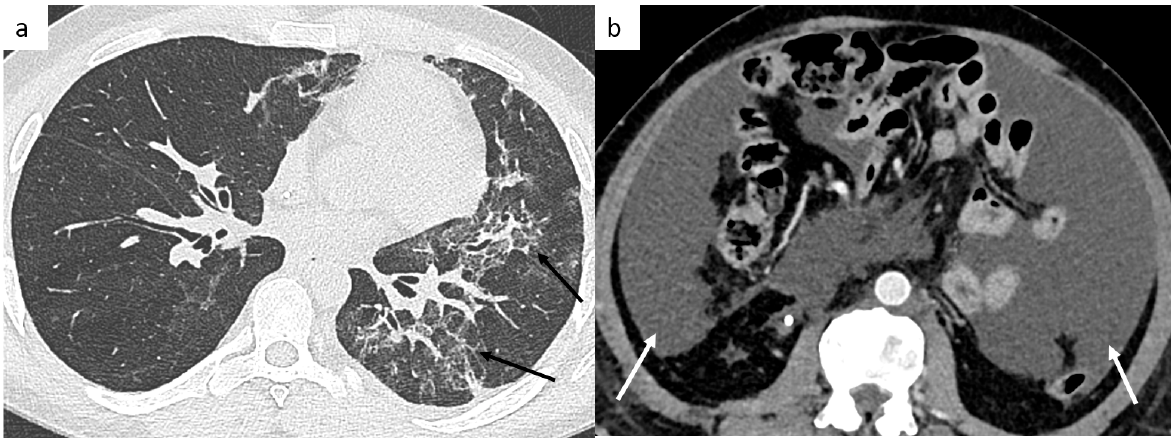
Figure 8. Post-treatment complications. Thoracic CT shows a bleomycin-induced interstitial pneumonitis ( a ) affecting left upper and lower lobes. Postoperative abdominal CT shows chylous ascites ( b ).